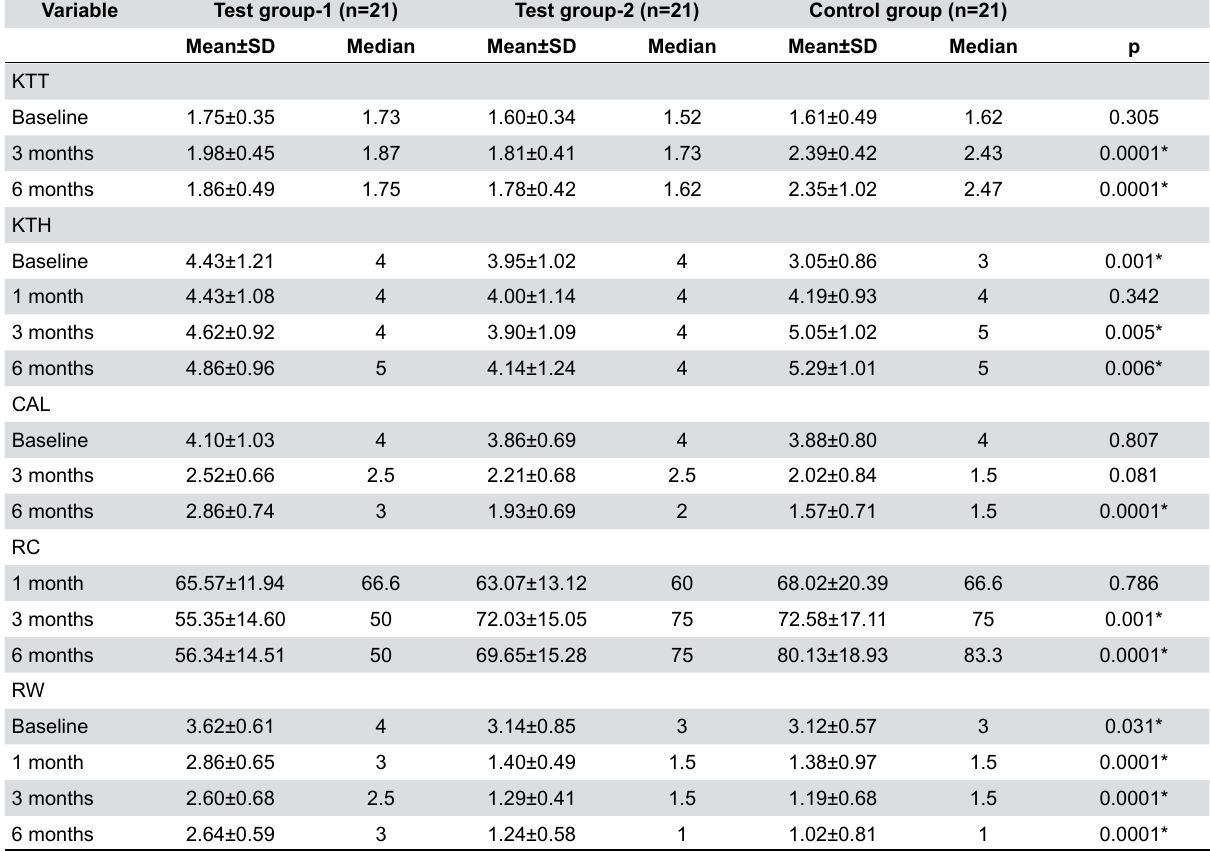
Table 2- Clinical evaluation of KTT, KTH, CAL, RC